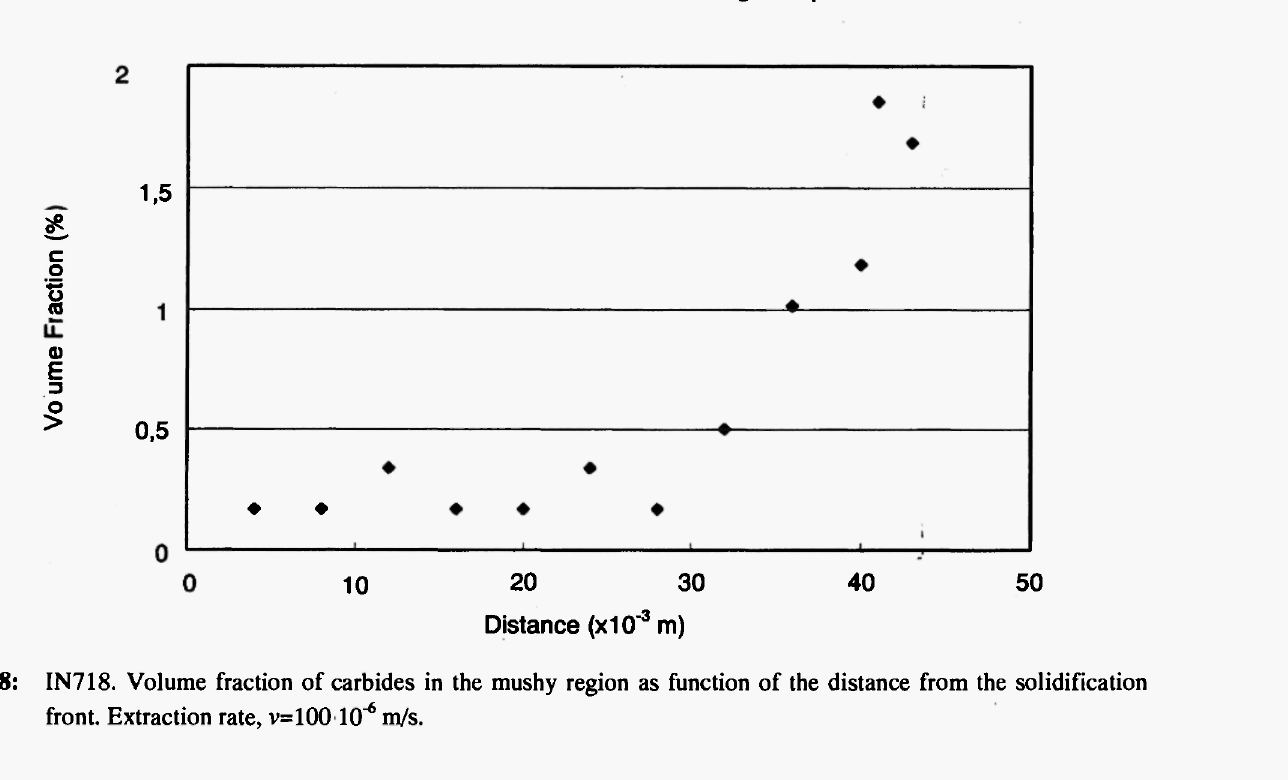
Fig. 18: IN718. Volume fraction of carbides in the mushy region as function of the distance from the solidification front. Extraction rate, v=10010" 6 m/s.